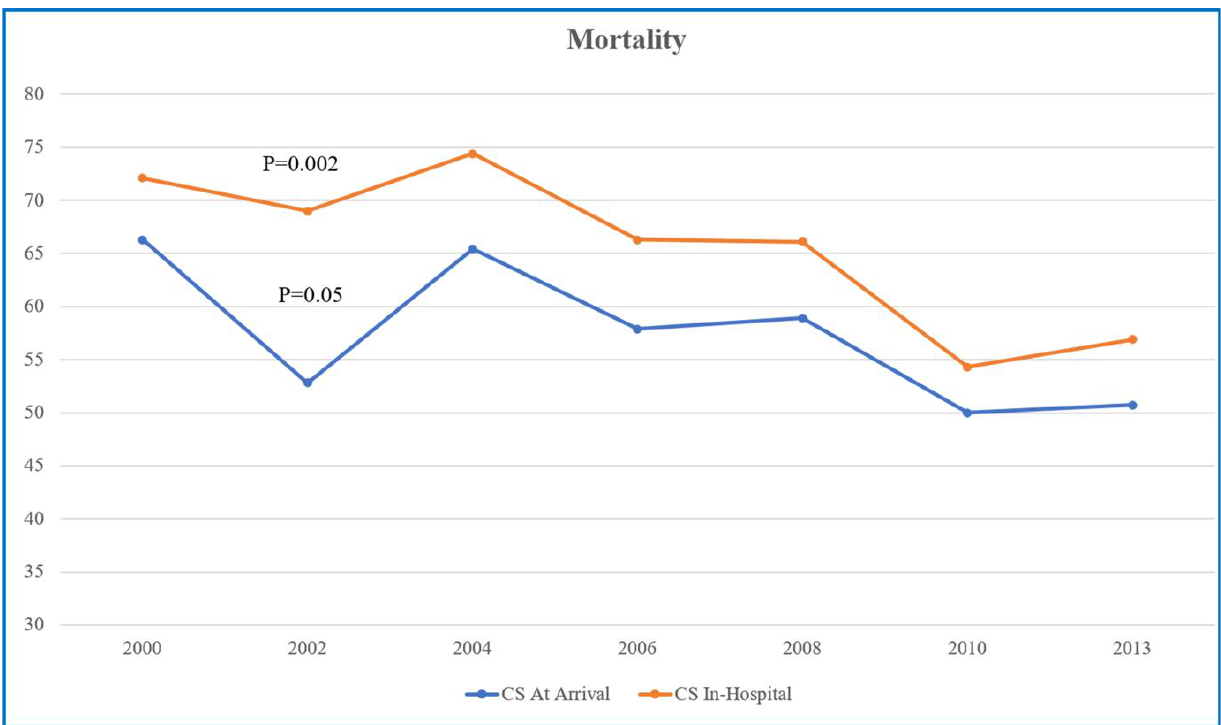
Figure 2. One-year mortality rates in ACS patients with CS at arrival (blue line) and ACS patients who developed CS during hospitalization (red line) between the years 2000 and 2013.